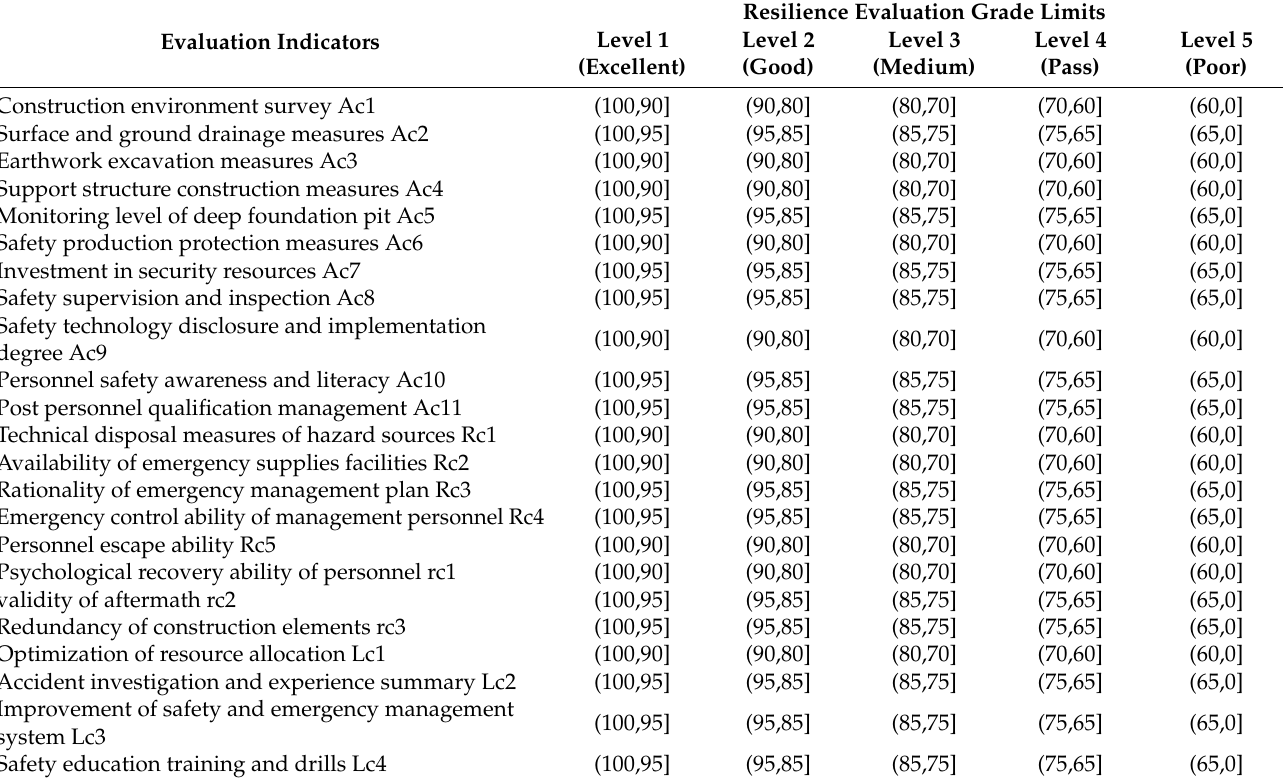
Table 7. Evaluation grade limit value of resilience index of deep foundation pit construction safety